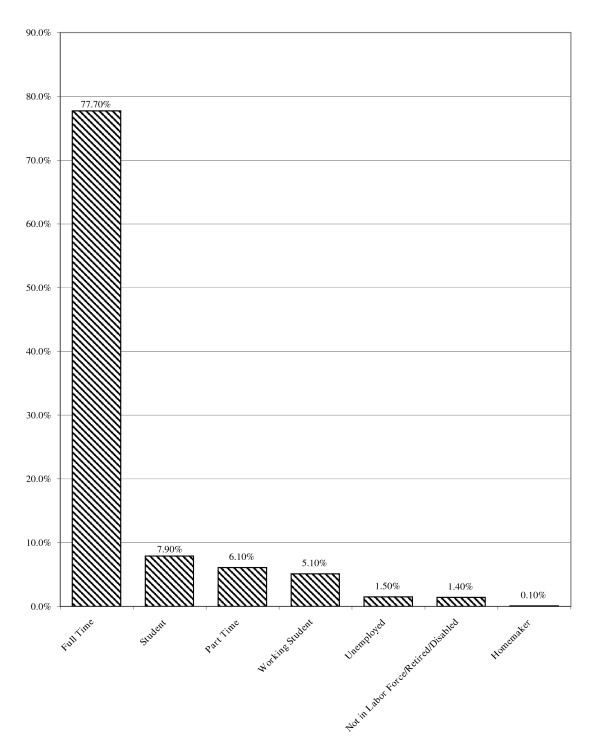
Employment Status.